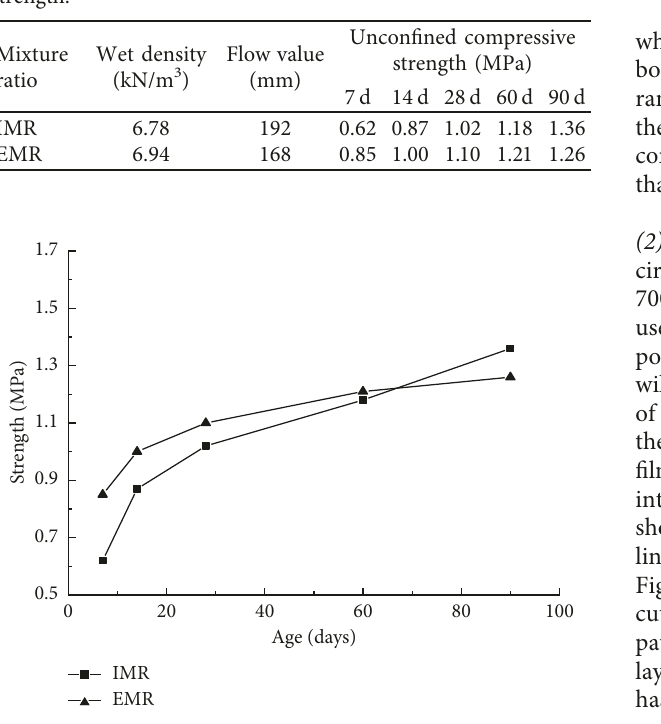
Figure 8: Strength changing with time.